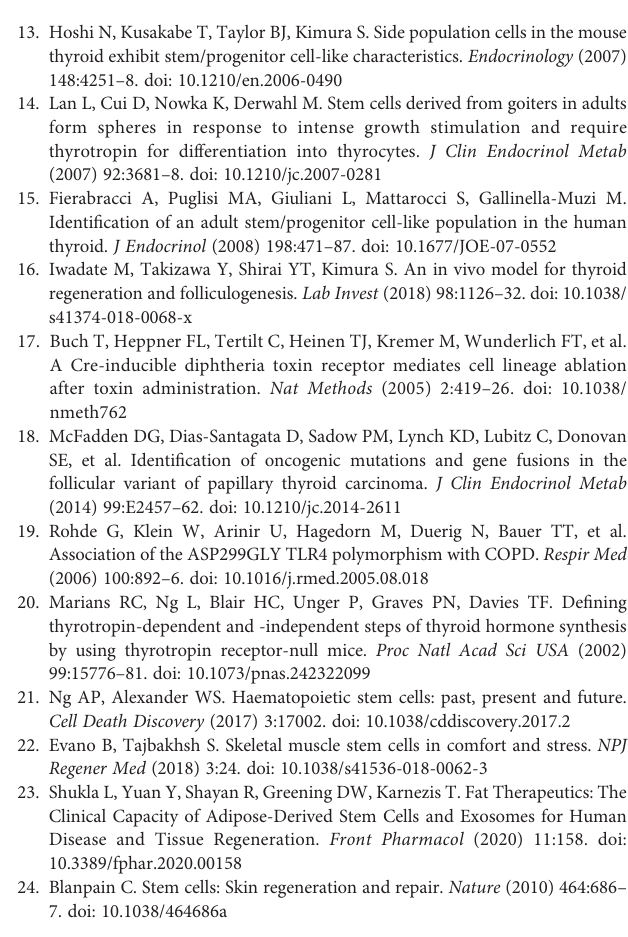
SUPPLEMENTARY FIGURE 1 | Representative genotyping of TPOCreER2/ iDTR mice by tail DNA. (A) The PCR for the DTR shows a 650 bp band for wild type and 340 bp band for mutant. (B) The PCR for Cre shows a 324 bp band for an internal control and 130 bp band for Cre. SUPPLEMENTARY FIGURE 2 | Analysis of DTR expression in the thyroid glands of TPOCreER2/iDTR mice. (A) qPCR analysis oftheDTR inTPOCreER2/iDTR mouse thyroid and control thyroid. (B) The RT-PCR products in 2% agarose gel. SUPPLEMENTARY FIGURE 3 | Release of thyroglobulin from damaged thyroid follicular cells. This fi gure illustrates the increased serum thyroglobulin levels from TPOCreER2/iDTR. mice treated with TM/DT for 2 and 4 weeks when compared to control